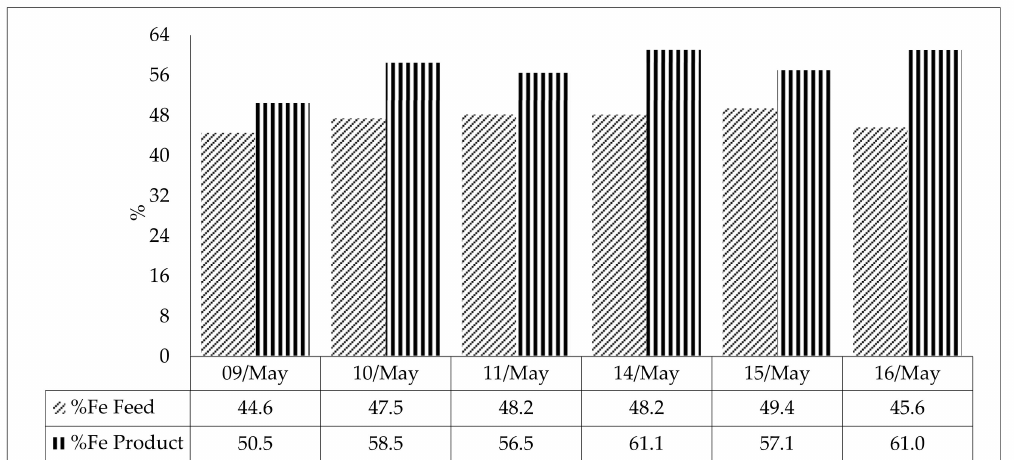
Figure 11. Fe content in feed and product.